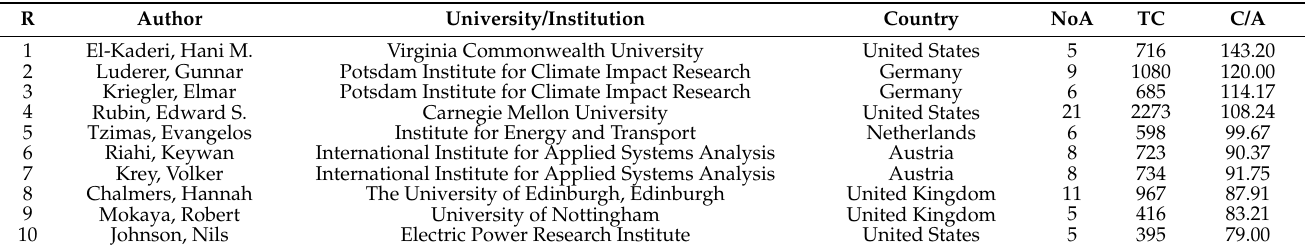
Table 3. Top ten most productive authors based on citations per article.